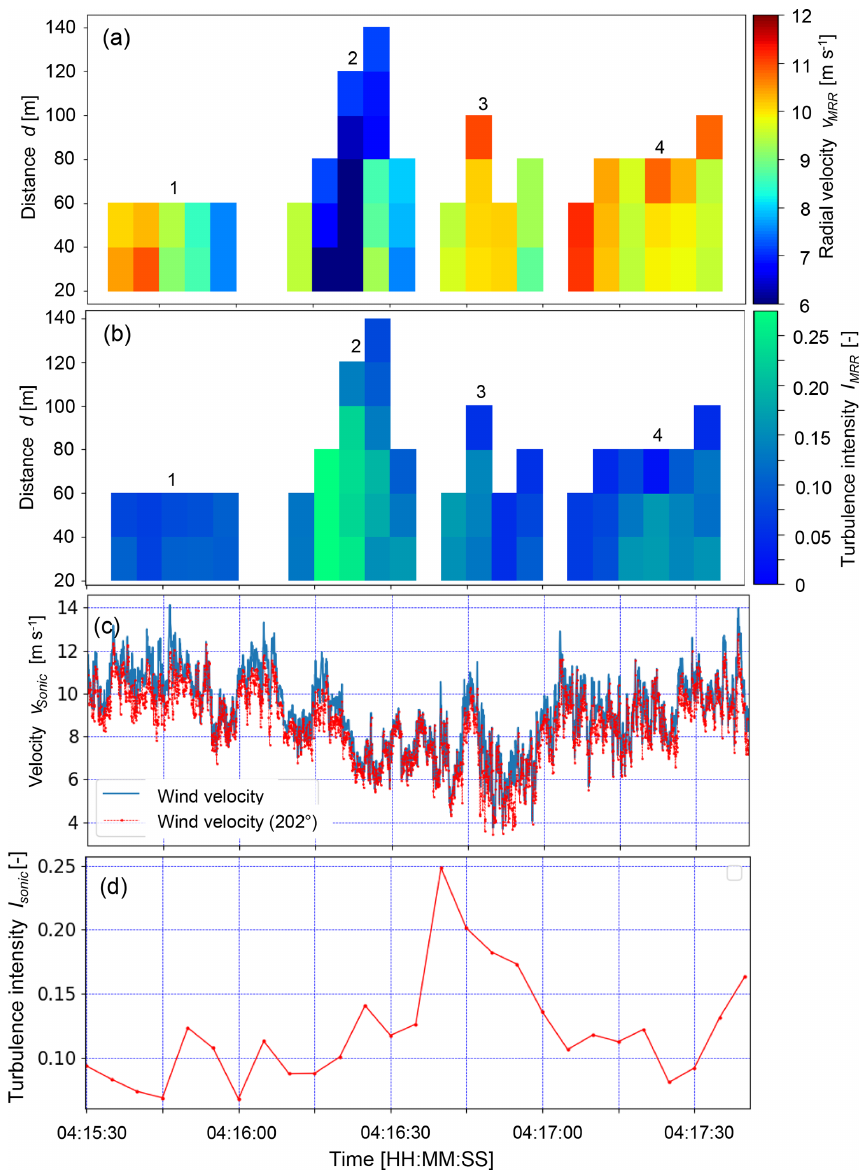
Figure 4. (a) MRR radial velocity in the azimuth direction 22 ◦ for a 2min period containing four different blowing snow events on 4 March 2019. (b) Corresponding turbulence intensity I , Sonic (c) wind velocity (absolute and in the direction 202 ◦ ) and (d) turbulence intensity for 5s